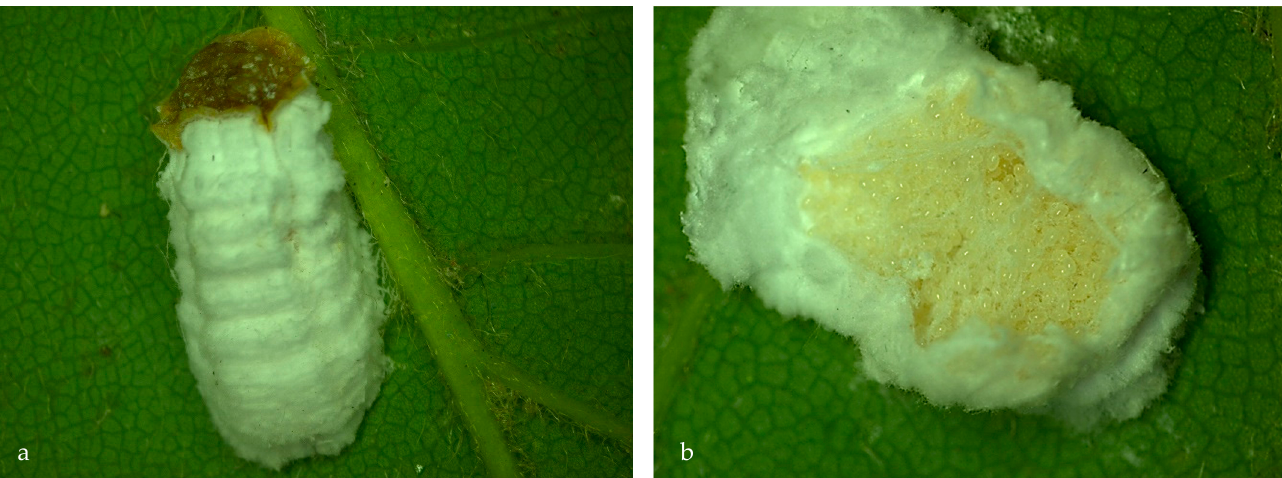
Figure 2. P. hydrangeae ovisacs on the underside of leaves of A. pseudolpatanus ( a , b ) and on the twigs and leaves of T. cordata ( c , d ).